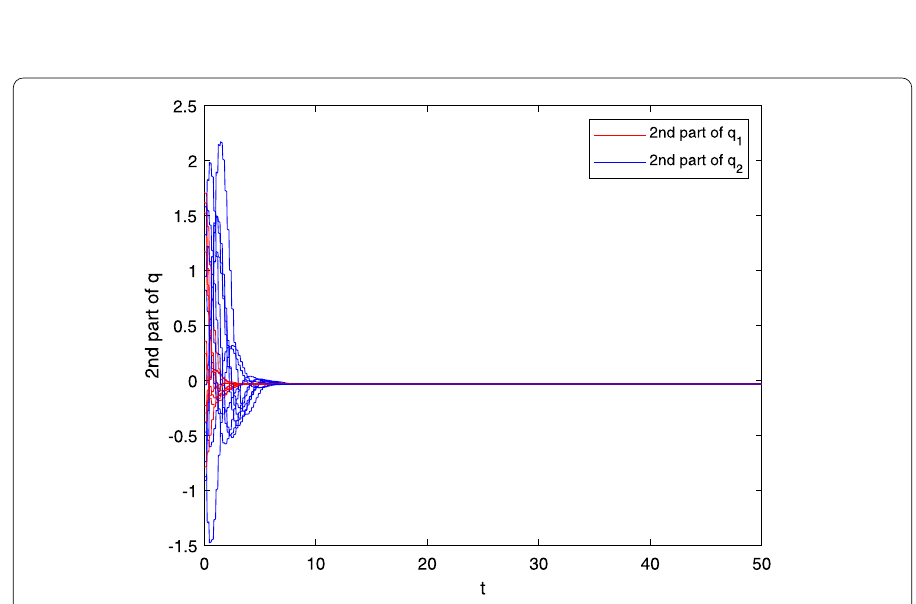
Figure 2 The second part of the state trajectories for system (1) with parameters